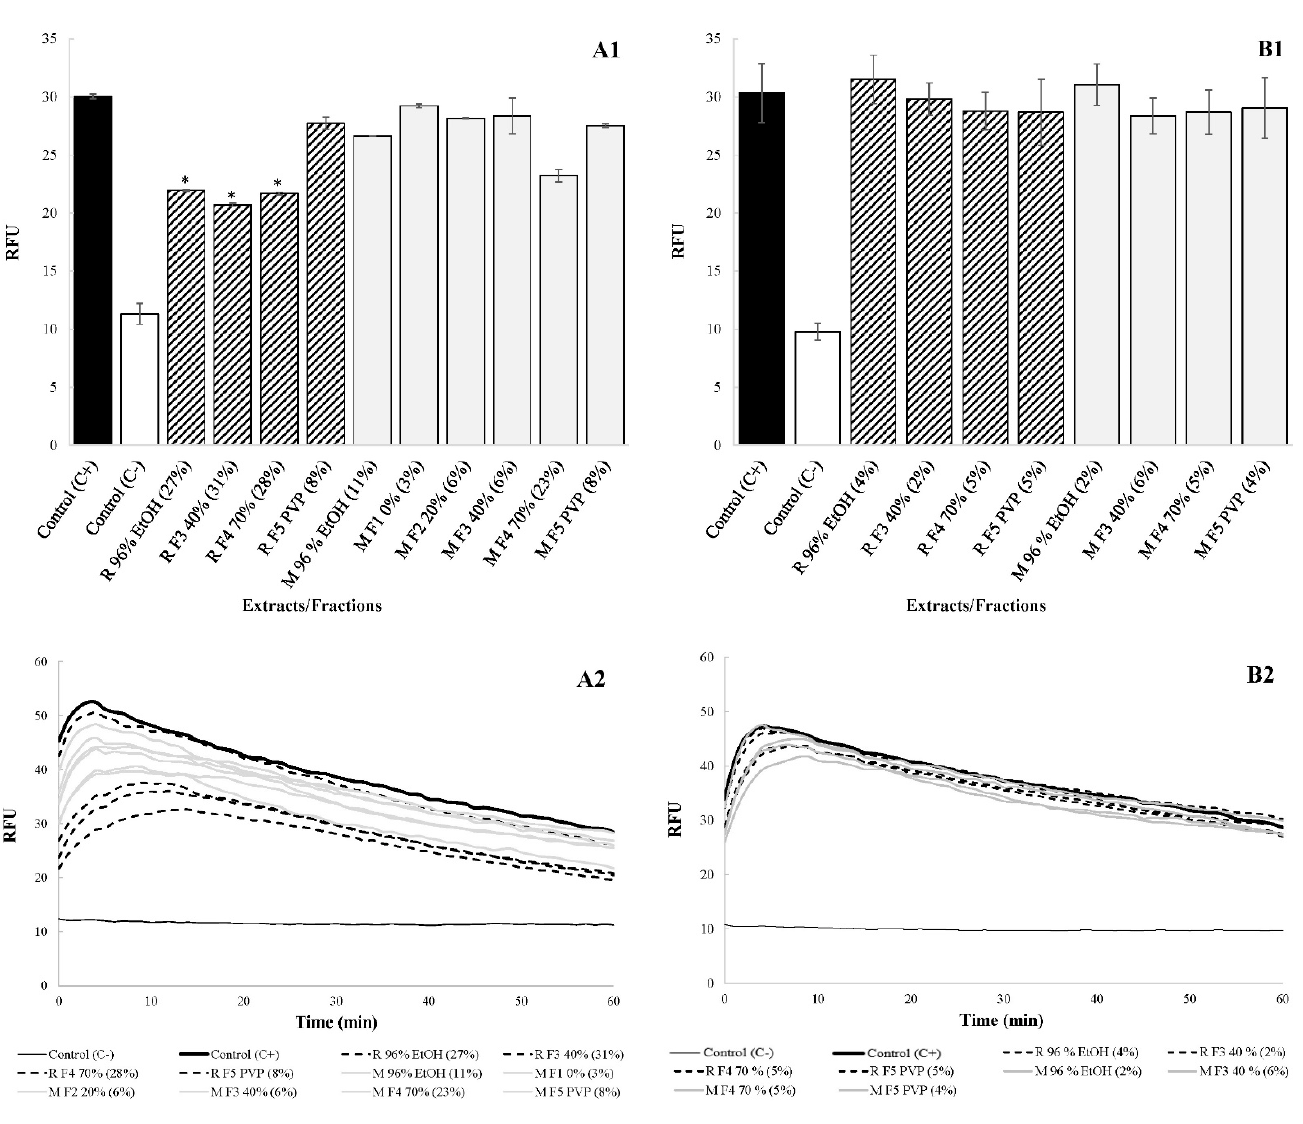
Figure 3. Influence of the extracts and their fractions on C. jejuni NCTC 11168 membrane integrity (( A1 / A2 ): preparations tested at 0.25× MICs; ( B1 / B2 ): preparations tested in the same concentration, i.e., 15.625 mg/L). An impact on membrane integrity in RFU is presented ± standard deviations. In addition, the decrease in membrane integrity is presented in brackets. * represents statistically significant